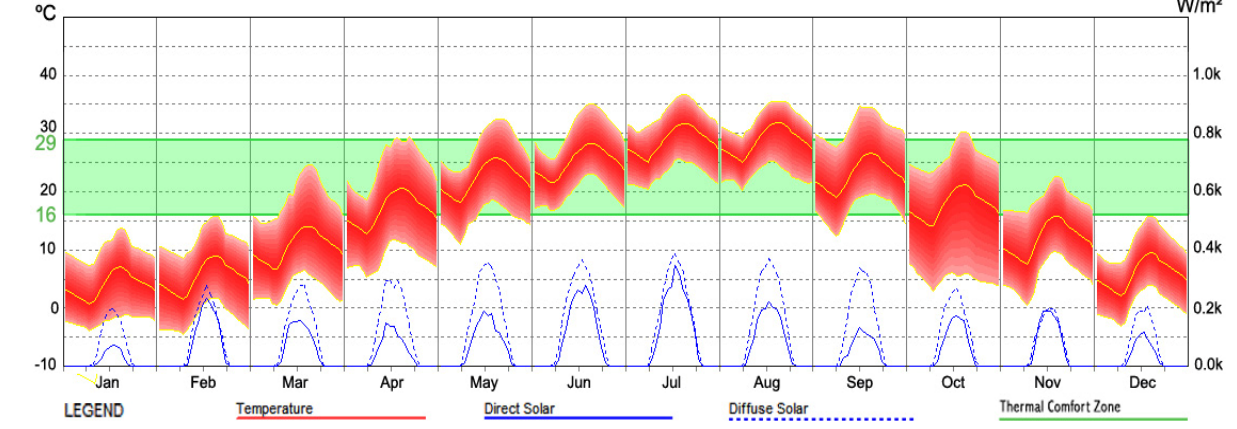
Figure 35. Wuhan Climate Data (MeteonormV6.1 data period: